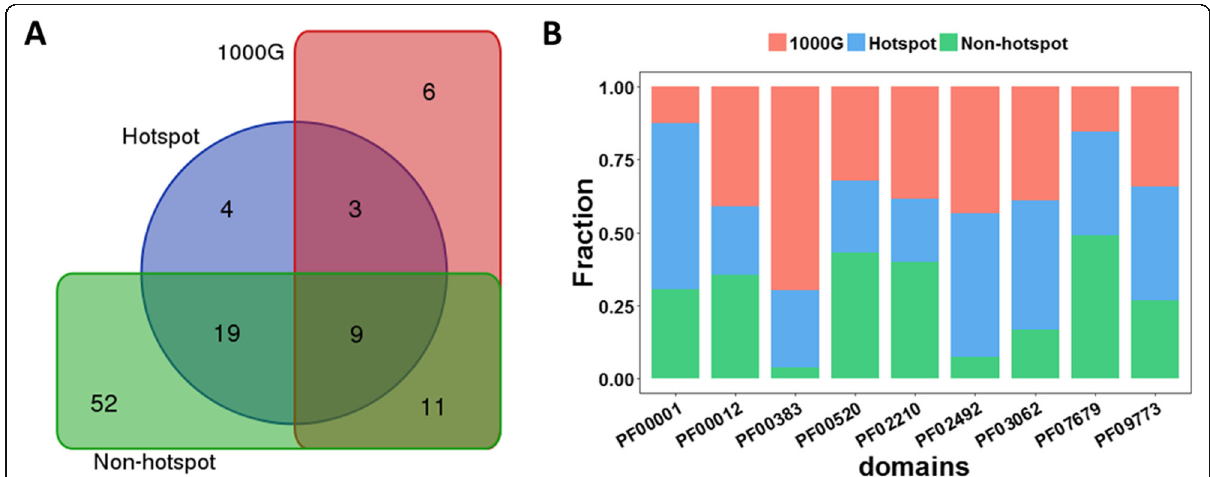
Fig. 7 Analysis of mutation distribution in protein domains. a Venn diagram showing the number of domain types for the multiple intersections among hotspot mutations, neutral synonymous mutations and non-hotspot mutations. b Bar diagram where the value 100% represents the total number of mutations in the nine protein domains common to hotspot, neutral synonymous and non-hotspot mutations. Blue, salmon and green sections on the bar represent which proportions of the total mutations are hotspot, neutral synonymous and non-hotspot mutations, respectively. PF00001, 7tm_1 domain; PF00383, dCMP_cyt_deam_1 domain; PF02492, cobW domain; PF00012, HSP70 domain; PF00520, Ion_trans domain; PF07679, I-set domain; PF00055, Laminin_N domain; PF03062, MBOAT domain; PF09773, Meckelin